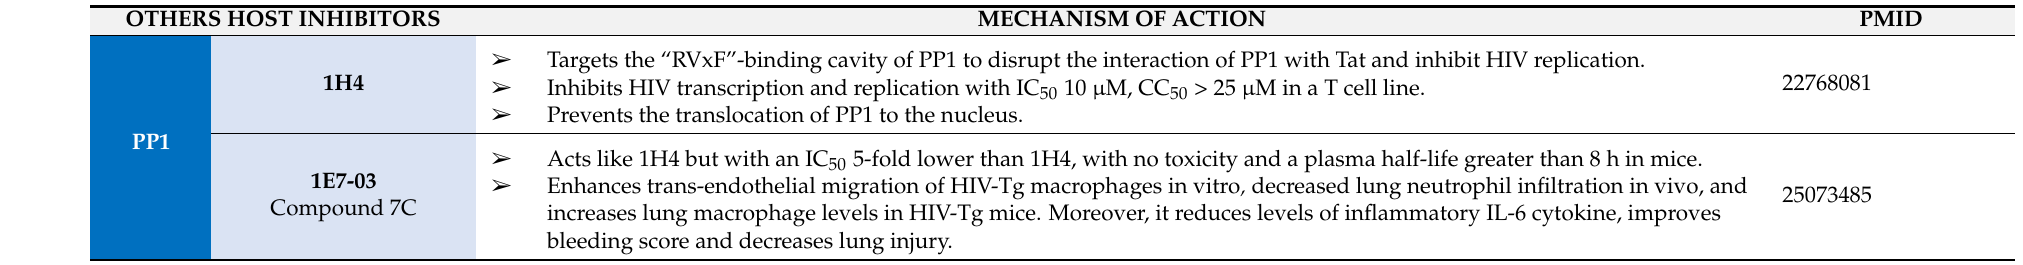
bleeding score and decreases lung